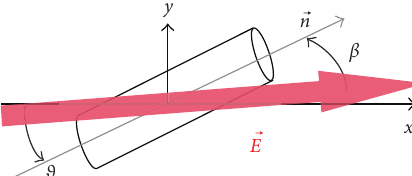
Figure 1: Representation of a rod like molecule with the anisotropic dielectric axes.